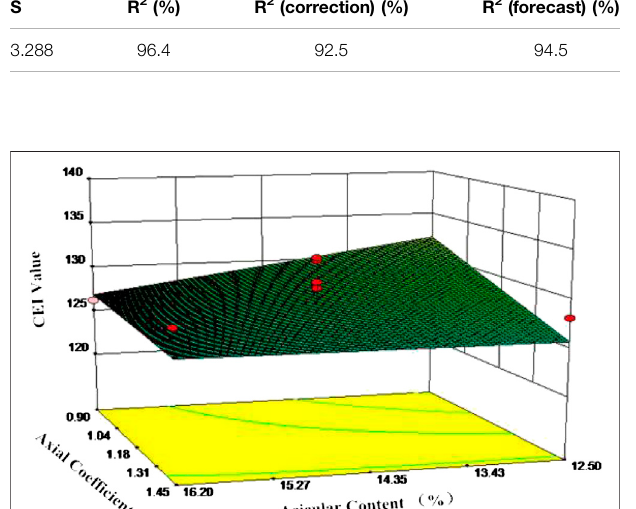
FIGURE 6 | Interaction between axial coef fi cient and needle fl ake content.